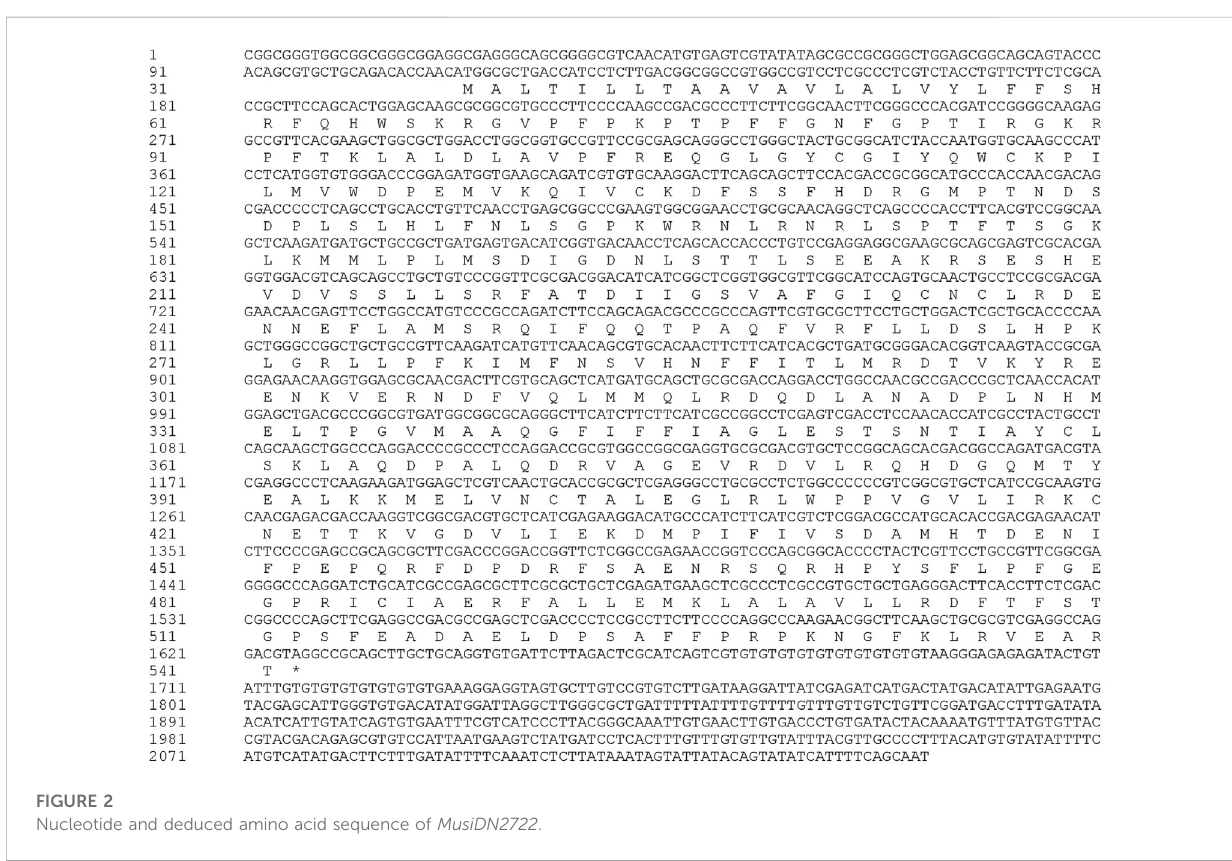
FIGURE 2 Nucleotide and deduced amino acid sequence of MusiDN2722